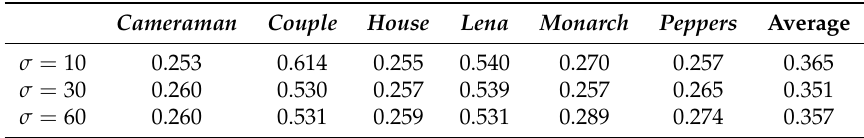
Table 9. Fusion time (s) of the proposed method for processing the six selected images with sizes of 256 × 256 and 512 × 512 with noise level σ = 10, 30, and